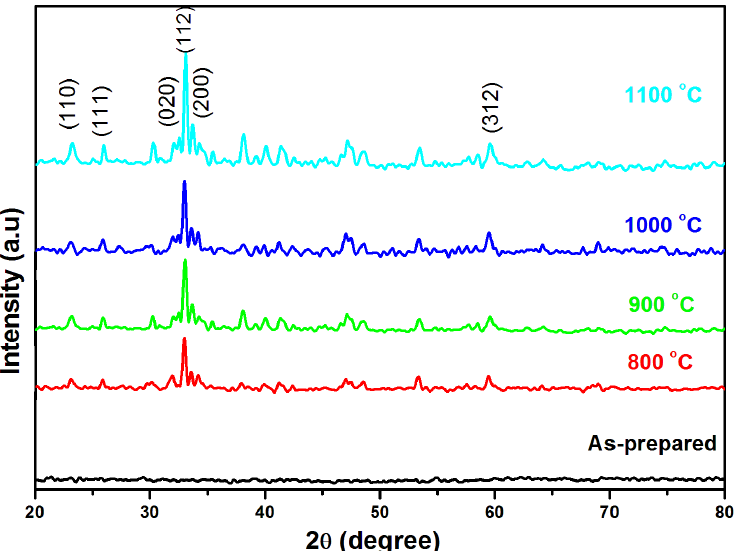
Figure 2. X-ray diffraction of gadolinium orthoferrite annealed at 800 °C, 900 °C, 1000 °C, and 1100 °C.